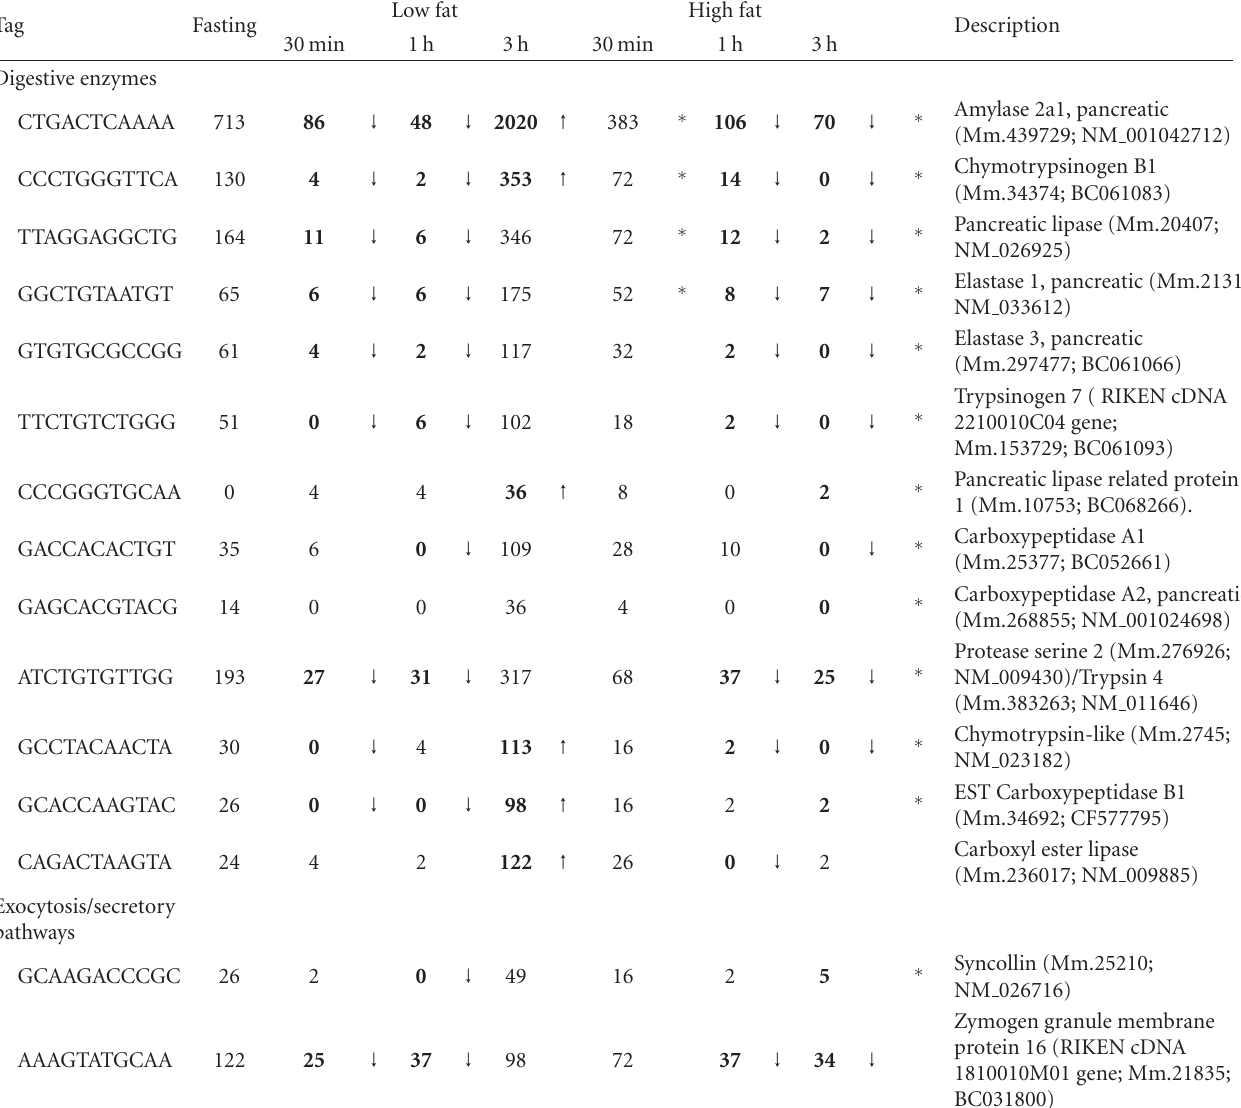
Table 1: Transcripts coding for digestive and secretory proteins di ff erentially modulated by feeding in the gastric mucosa.